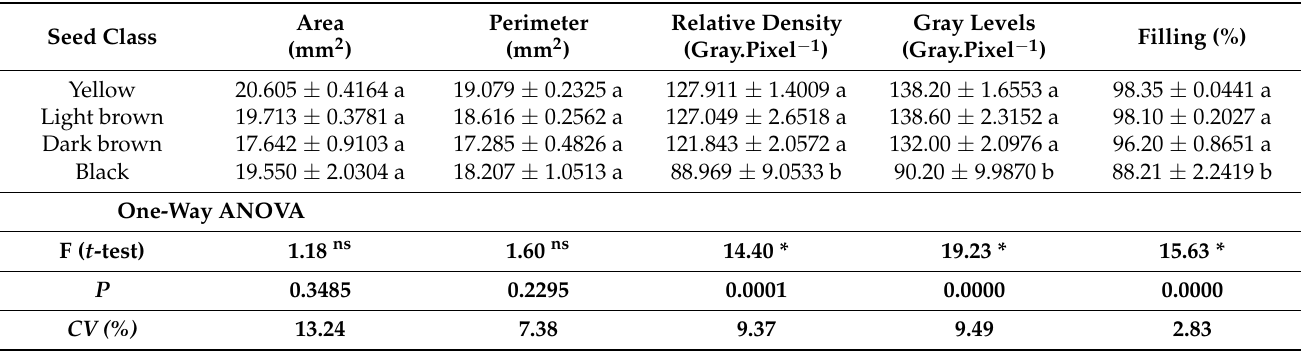
Table 3. Area, perimeter, relative density, gray levels and filling values for yellow, light brown, dark brown and black Pterodon pubescens seeds.